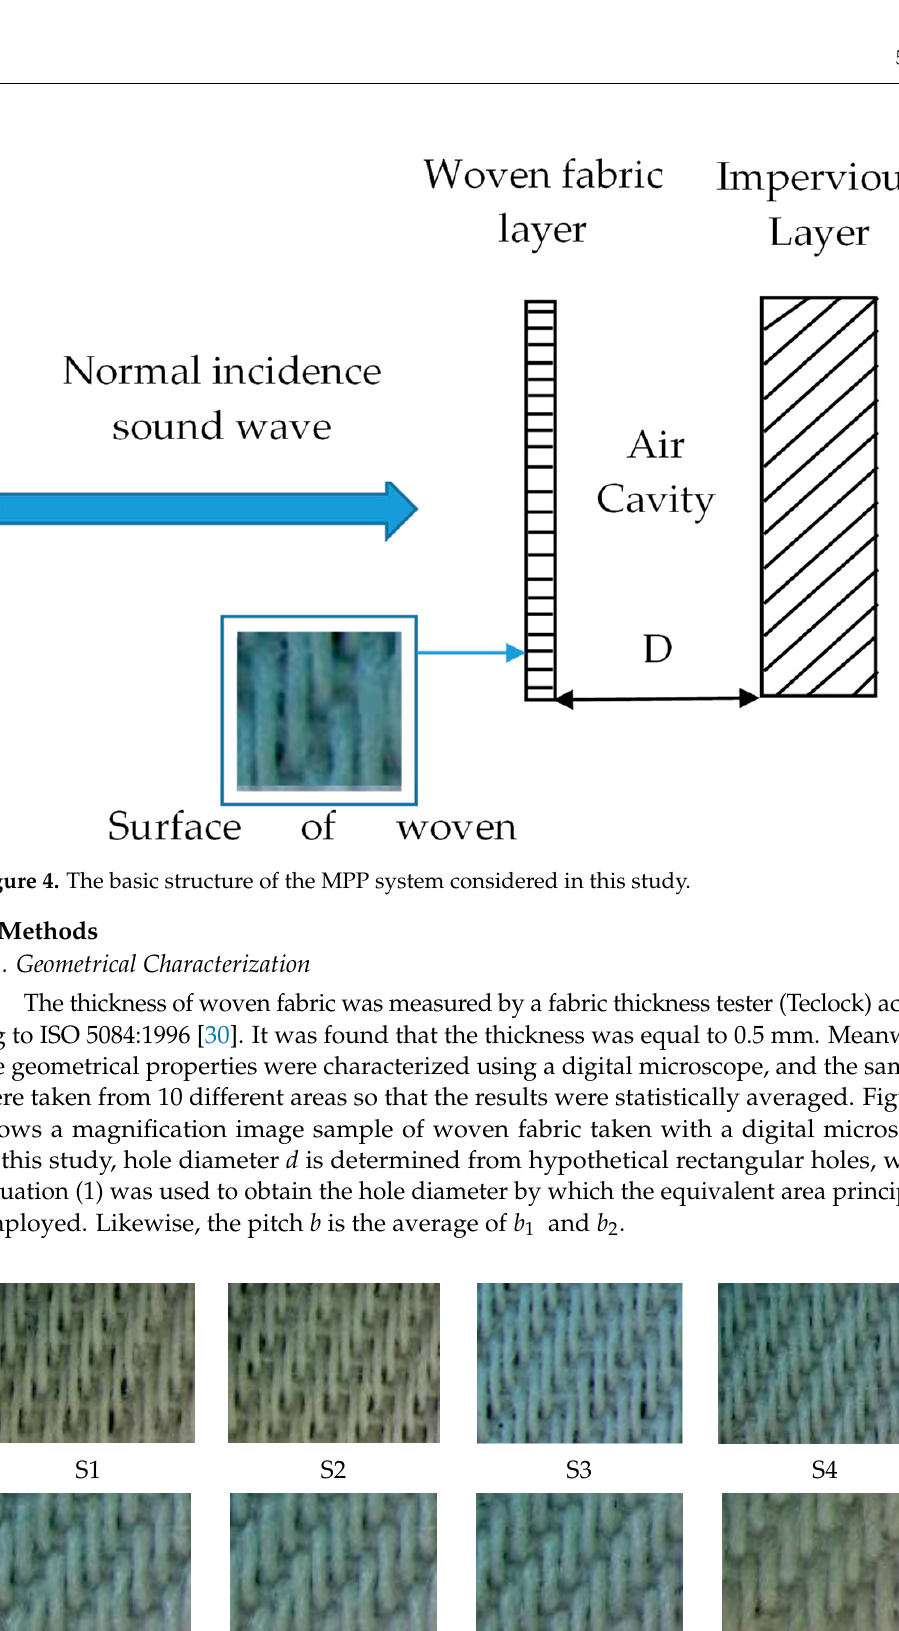
S8 Figure 5. Magnification of images of eight woven fabric samples with different weft densities. The dark area indicates holes, otherwise the images consist of yarn. The magnification sample S5–S8 is displayed bigger than S1–S4. 3.2. Flow Resistance Measurement Flow resistance is an important parameter affecting sound absorption behavior. In this study, the flow resistance s R was estimated from the measurement of air permeabil- ity of textiles using the following equation [31] :